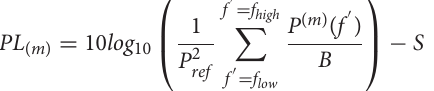
( Figure 1 ). Gigante seamount, located 100 km west-northwest